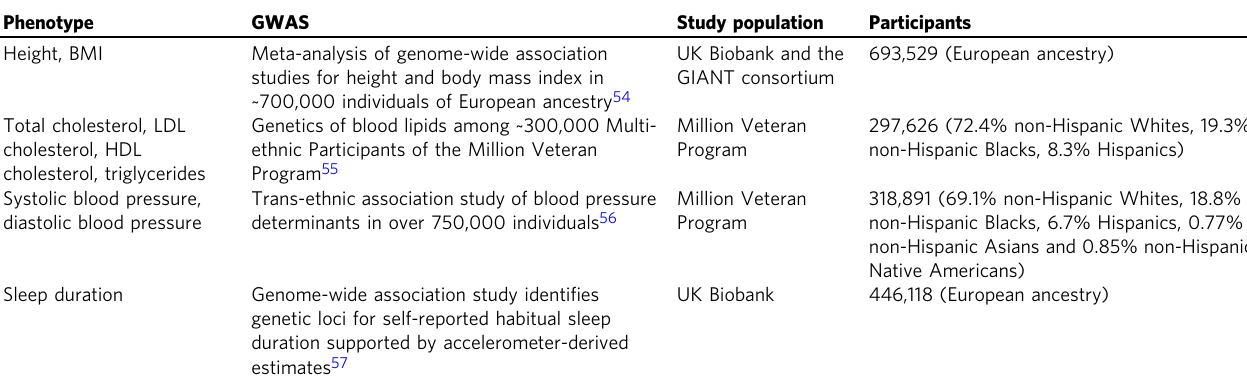
Table 3 Description of published GWAS used to identify summary